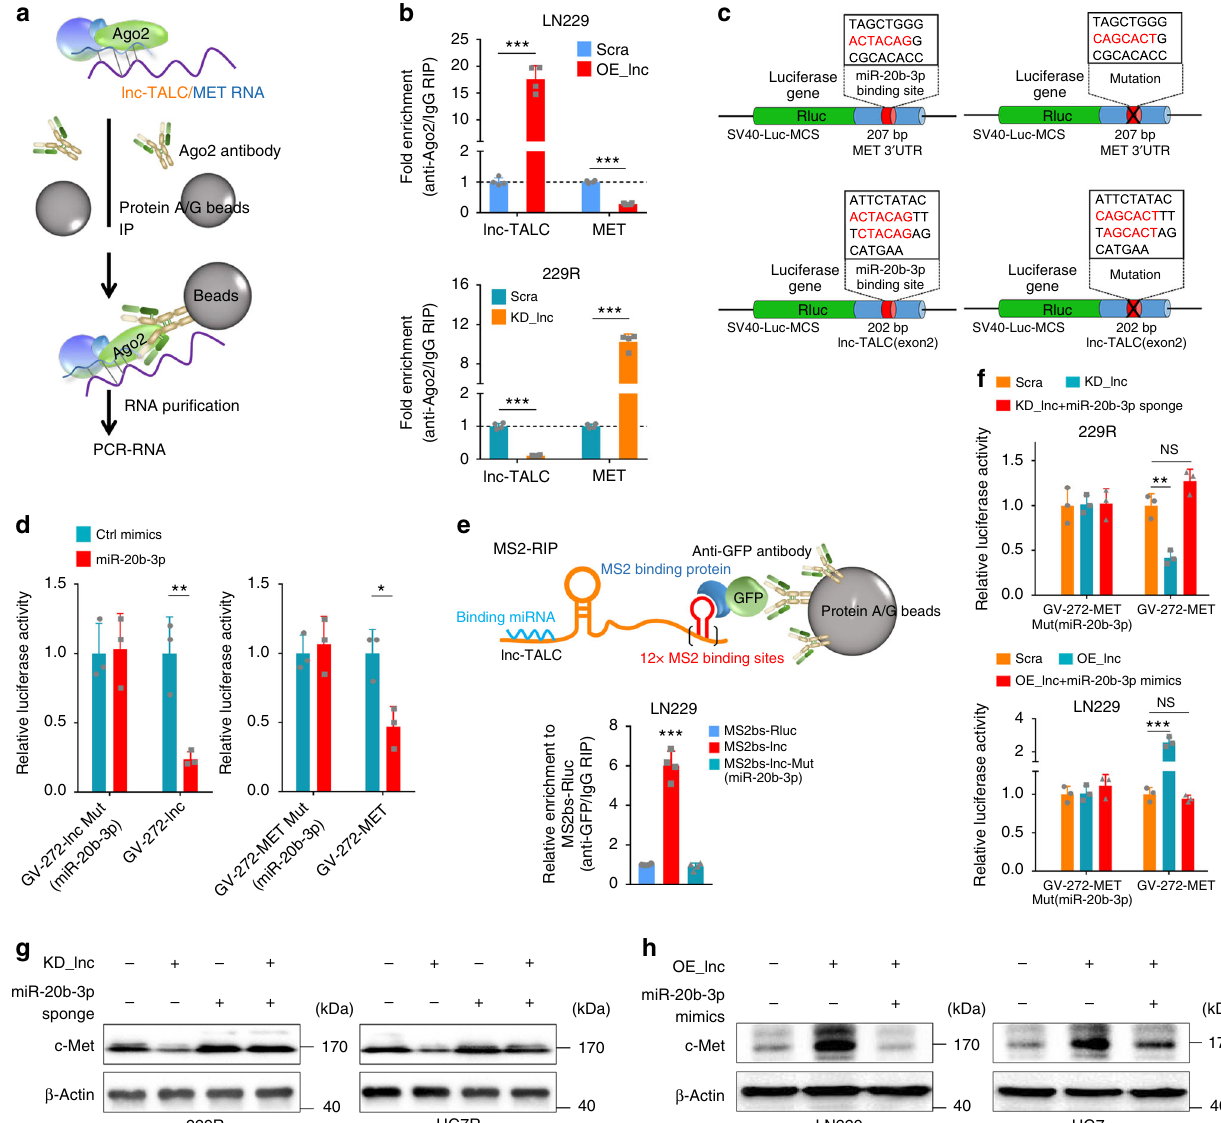
Fig. 5 Lnc-TALC competitively binds miR-20b-3p targeting the MET 3 ′ UTR region. a Schematic process of the RIP-PCR assay. b RIP-PCR assay of the enrichment of Ago2 on lnc-TALC and c-MET transcript normalized to IgG in LN229 or 229R cells transfected with LV-scramble, or LV-lnc-TALC or LV- CRISPR-lnc-TALC ( n = 4). c Schematic outline of predicted and mutant binding sites for miR-20b-3p on lnc-TALC and MET. d Luciferase activity of GV- 272-lnc-TALC or GV-272-MET upon transfection of control mimics and miR-20b-3p in 229R ( n = 3). e Upper: Schematic process of the MS2-RIP assay. Lower: MS2-based RIP assay with anti-GFP antibody in LN229 cells 72 h after transfection with MS2bs-Rluc, MS2bs-lnc-TALC or MS2bs-lnc-TALC-Mut ( n = 4). f Upper: Luciferase activity of GV-272-MET in 229R lnc-TALC knockdown upon transfection of a miR-20b-3p sponge ( n = 3). Lower: Luciferase activity of GV-272-MET in LN229 overexpressing lnc-TALC upon transfection of miR-20b-3p mimics ( n = 3). g Western blot analysis of c-Met in 229R and HG7R cells transfected with LV-CRISPR-lnc-TALC or a miR-20b-3p sponge. h Western blot analysis of c-Met in LN229 and HG7 cells transfected with LV- lnc-TALC or miR-20b-3p mimics. Data are presented as the mean ± S.D. P value was determined by Student ’ s t -test or one-way ANOVA. Signi fi cant results were presented as NS non-signi fi cant, * P < 0.05, ** P < 0.01, or *** P <